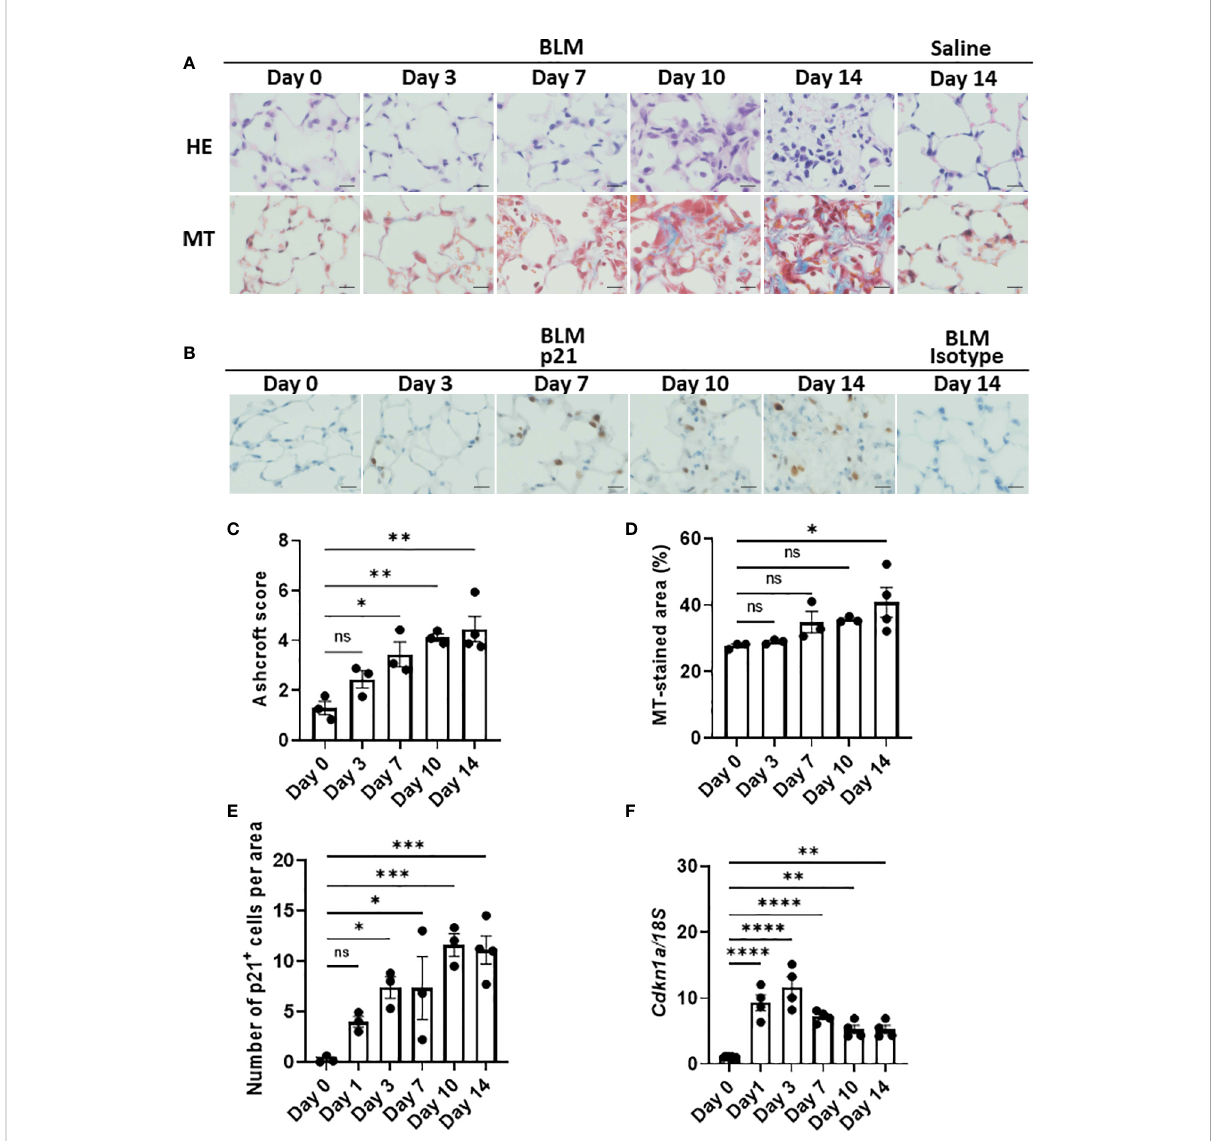
FIGURE 1 Emergence of p21WAF1/CIP1+ cells in lungs in the early phase of bleomycin-induced ILD (BLM-ILD).C57BL/6 mice were intratracheally instilled with BLM to induce BLM-ILD. Control mice were intratracheally instilled with saline. The lungs were obtained before and 1, 3, 7, 10, and 14 days after the instillation of BLM and 14 days after the instillation of saline. (A) Representative images of hematoxylin and eosin (HE) and Masson ’ s trichrome (MT) staining of paraf fi n-embedded lung tissue on the indicated days. (B) Representative images of the immunohistochemical staining of p21WAF1/CIP1 of lung tissue from mice on the indicated days. (C) The Ashcroft scale using MT-stained lung tissue from pooled mice. (D) Percentage of the collagen fi ber area in MT-stained lung tissue. The MT-stained area was measured by ImageJ in 20 randomly selected areas (360 × 240 µm) and the average was plotted. (E) Number of p21WAF1/CIP1+ cells per area of the right lung from pooled mice. p21WAF1/CIP1+ cells were counted in 10 randomly selected areas (180 × 120 µm) and the average was plotted. (F) Cdkn1a expression relative to 18S rRNA (18S) of the lung by quantitative RT-PCR (qRT-PCR). Scale bars indicate 5 µm. n = 3 – 4 per day (C – E) ; n = 4 per day (F) . Data are presented as the mean ± SEM. Statistics show p-values from a one-way ANOVA with Dunnett ’ s multiple comparisons test as a post-hoc test comparing values on day 0. ns, not signi fi cant. *p < 0.05; **p < 0.01; ***p < 0.001; ****p <